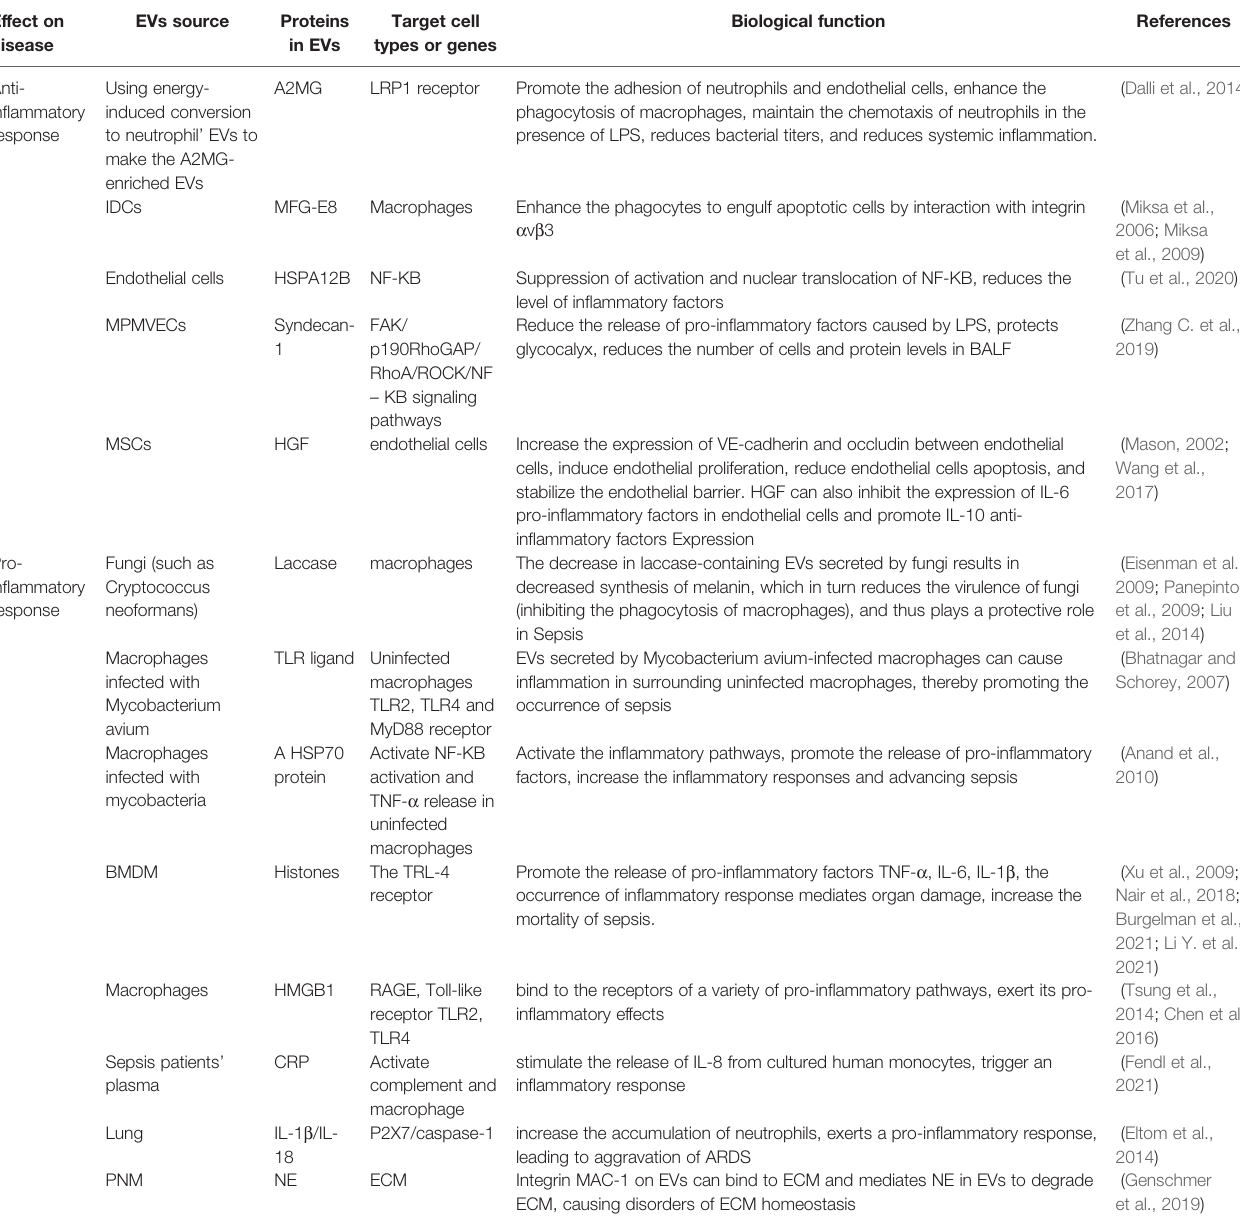
TABLE 2 | The proteins of EVs in sepsis and